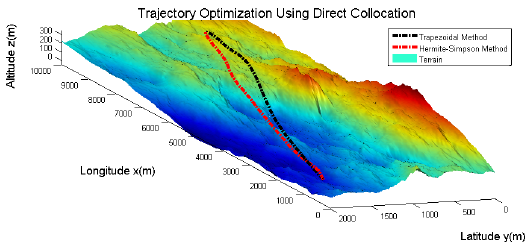
Figure 2. Schematic of the three-dimensional trajectory with the terrain